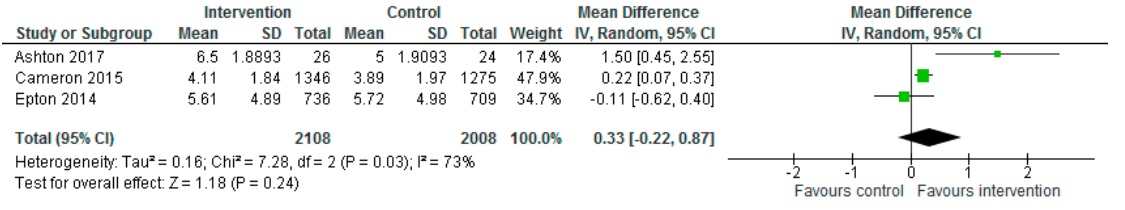
Figure 4. Meta-analysis of daily servings of fruit and vegetables.